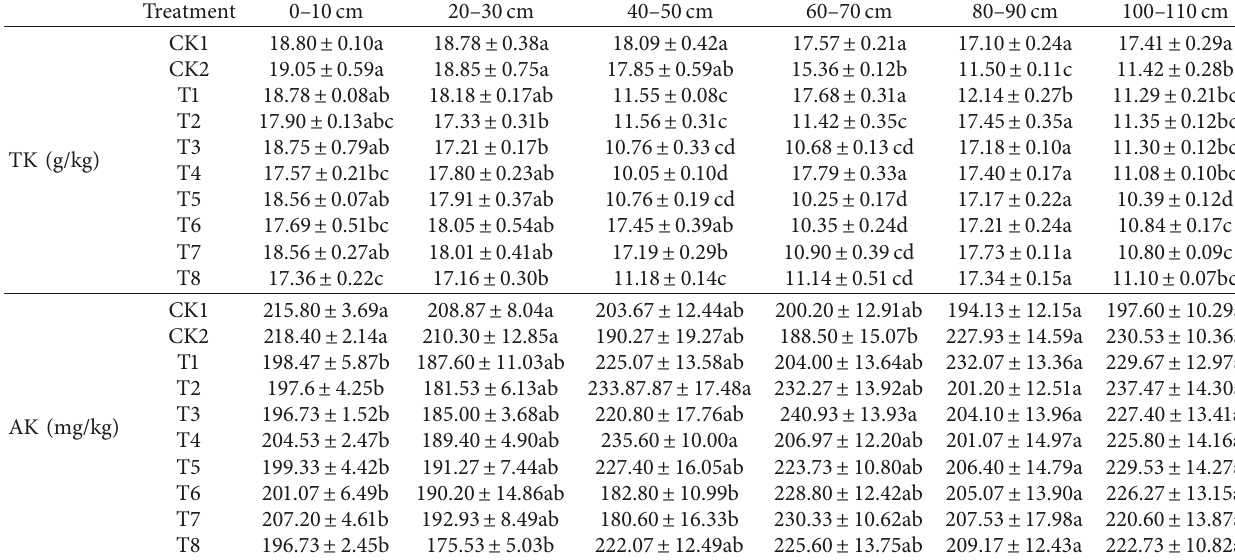
Table 6: Total and available potassium of interlayered soil